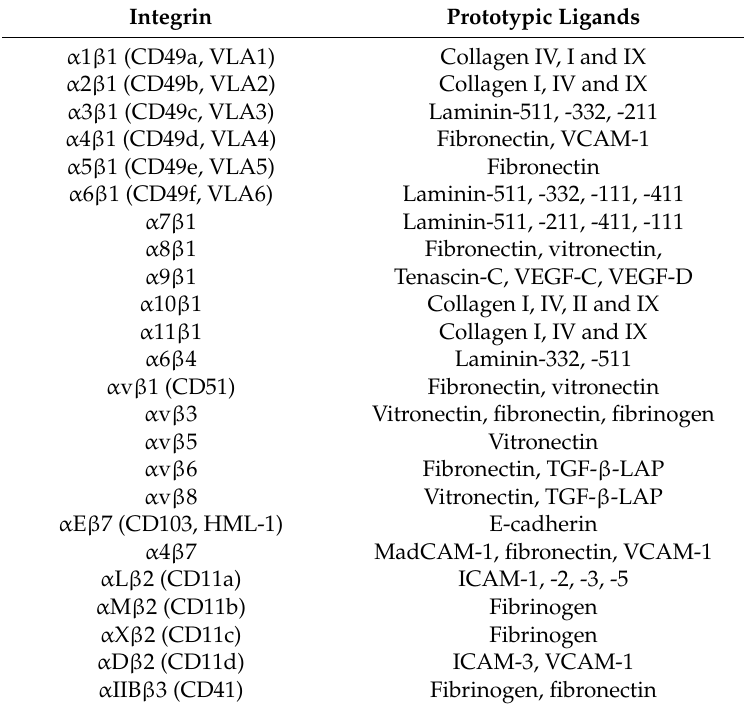
Table 1. Ligand specificity of